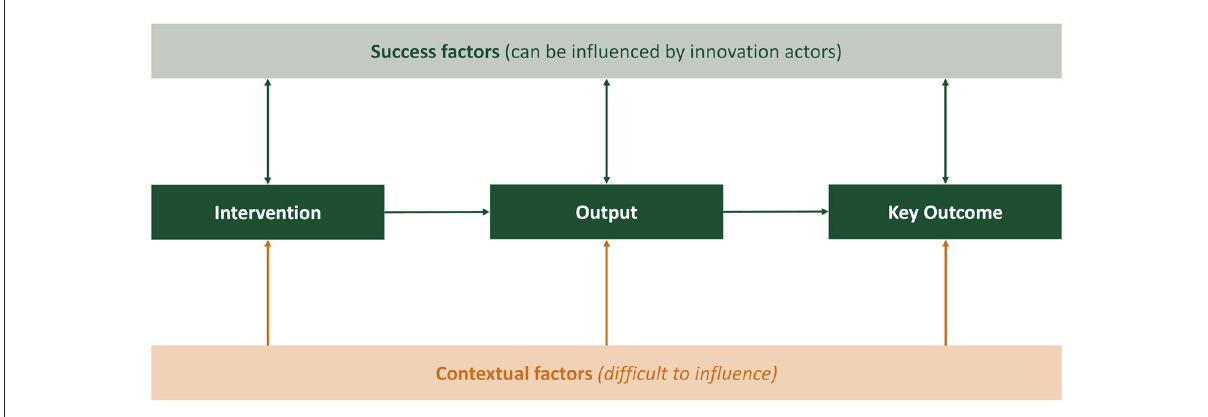
FIGURE1 A modified version of the results chain, which additionally shows how various factors, inside or outside the scope of the influence of innovation actors, affect the results of an